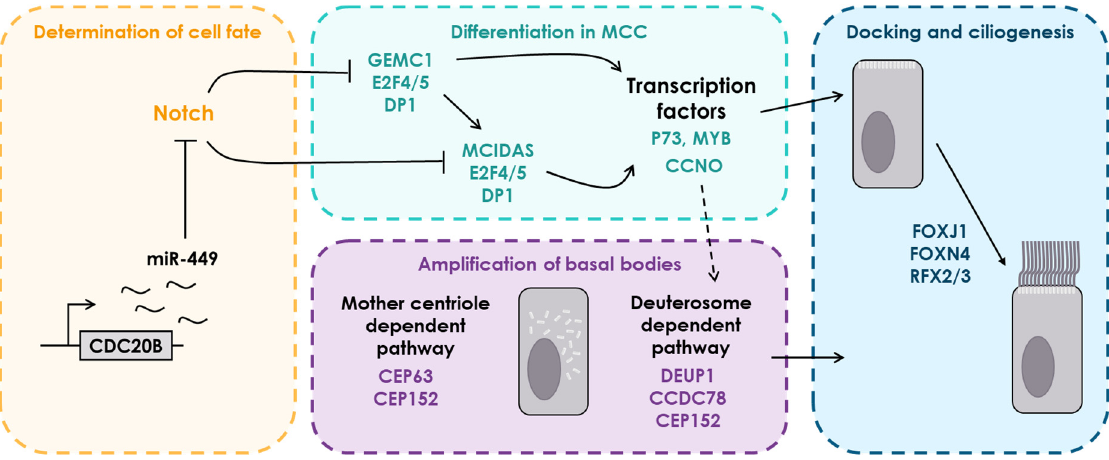
Figure 2. Schematic representation of the main stages of multiciliogenesis, with major genes. Flat-ended arrows depict the repression of a gene, regular arrows depict the activation of a gene.